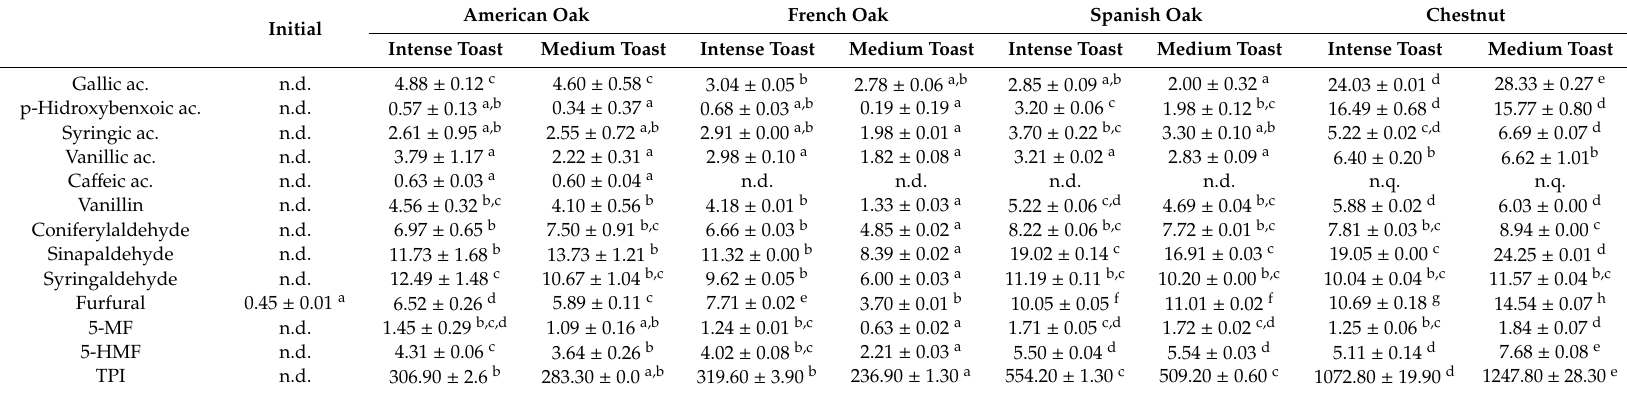
Table 2. Phenolic compounds contents (mg / L) and total polyphenol index (TPI) (mg / L gallic acid equivalent) of distillates ageing in barrel of American, French and Spanish oak, and Chestnut.